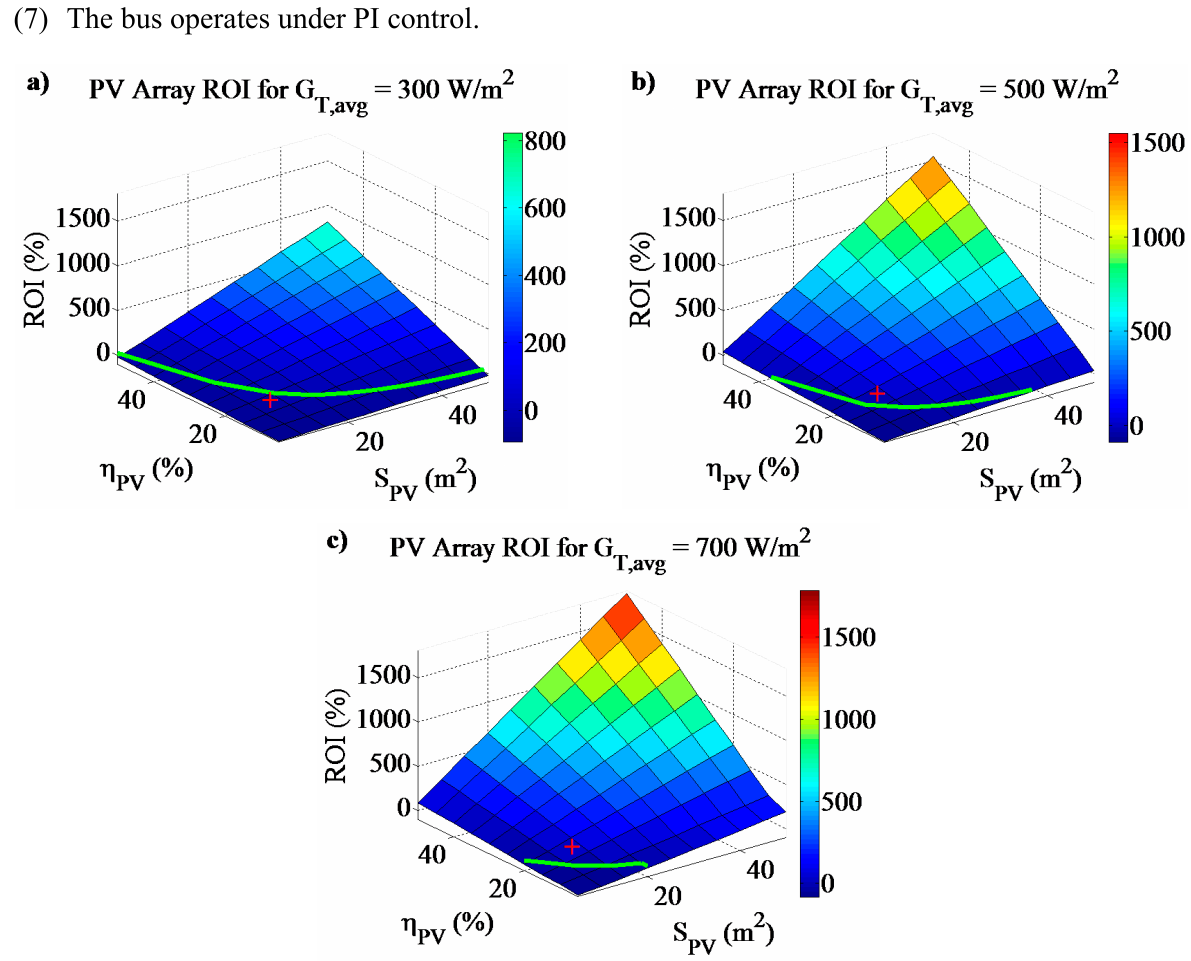
Figure 13. Plots of return on investment (ROI) as a function of PV efficiency ( surface area ( ) for three different values of average solar irradiance ( operation: ( a ) 300 W/m 2 ; ( b ) 500 W/m 2 ; and ( c ) 700 W/m 2 . The green line in each figure 𝑆𝑆 𝑃𝑃𝑃𝑃 represents the intersection between the ROI = 0% plane and the ROI surface plot. The red plus sign in each figure represents the characteristics of the PV array used in this work = 18.3% and = 13.12 m 2 ). For such a PV array, when = 300 W/m 2 the ROI ( is when the ROI is 30% and η 𝑃𝑃𝑃𝑃 𝑆𝑆 𝑃𝑃𝑃𝑃 80%,